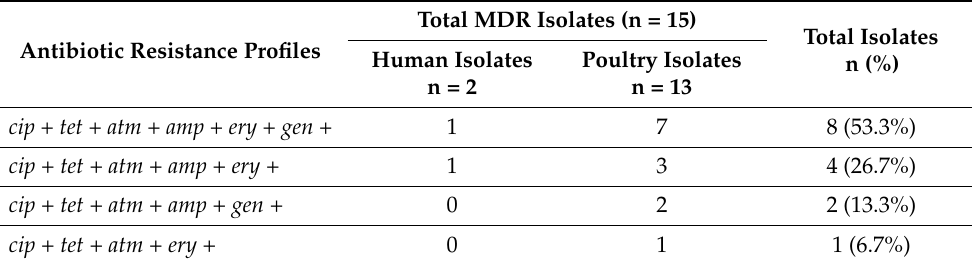
Table 4. Antibiograms of Campylobacter jejuni isolated from humans and chickens.